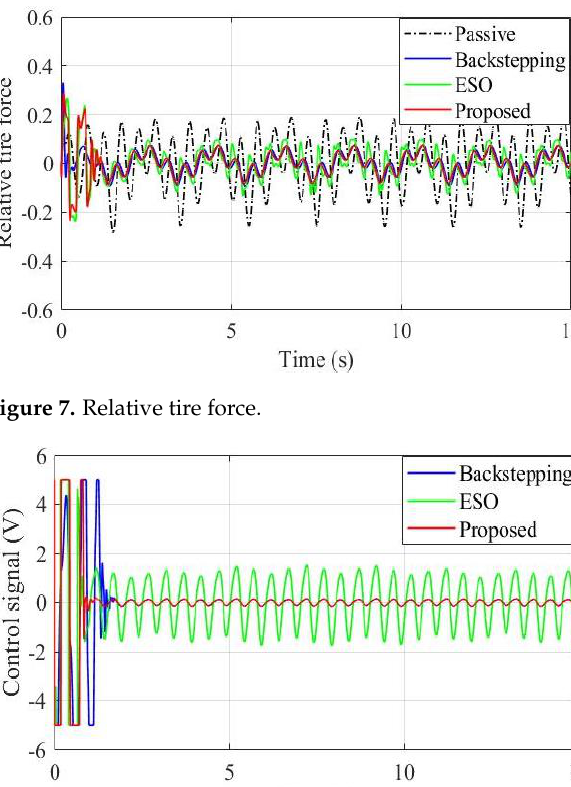
Figure 6. Relative suspension deflection.